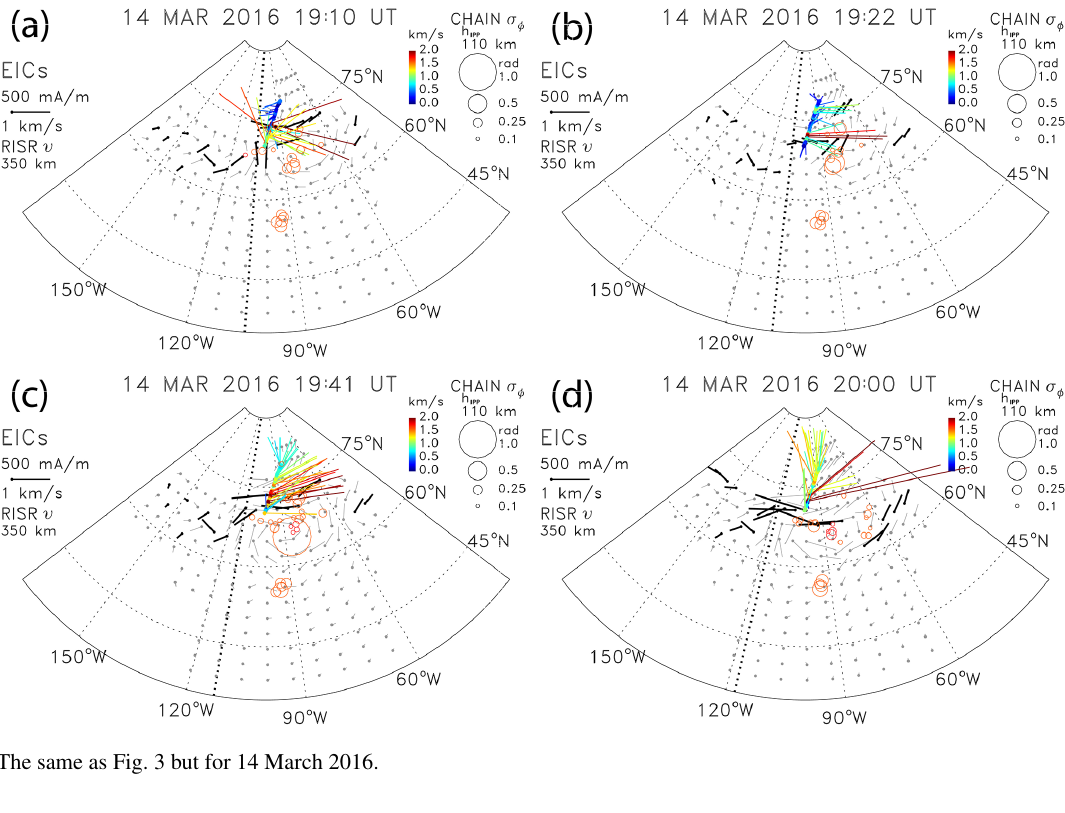
Figure 5. The same as Fig. 3 but for 14 March 2016.